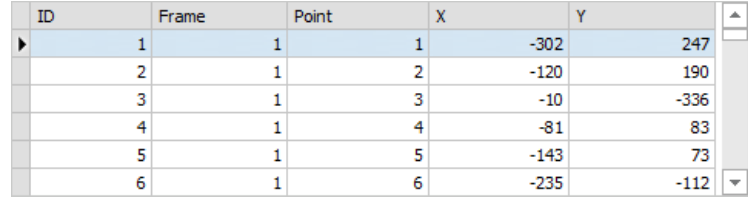
Figure 3. The “stimulus” relation after transformation of the PF